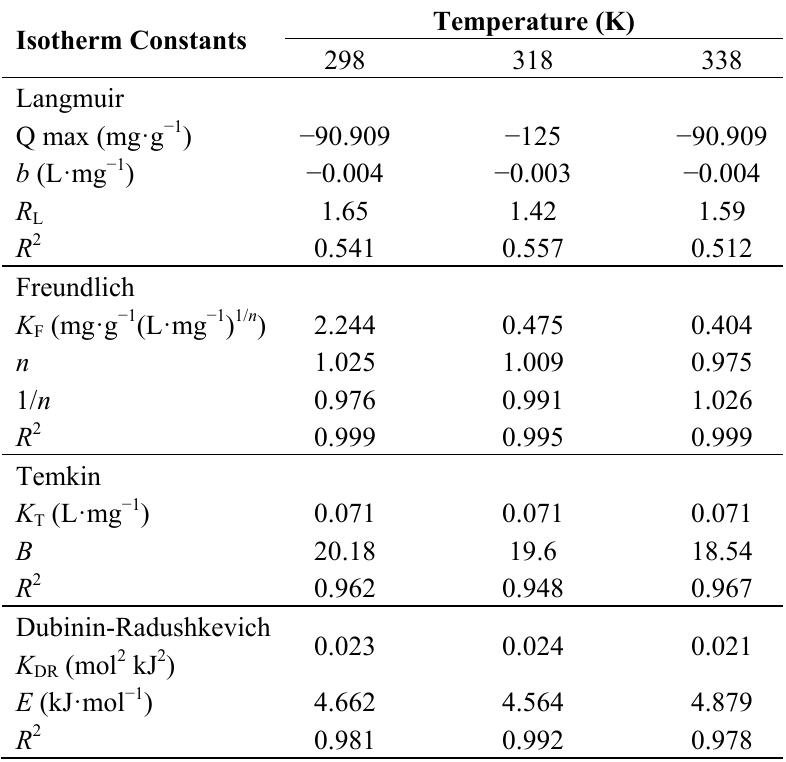
Table 1. Isotherm constants of four isotherm models for 2,4-DCP adsorption onto MIP